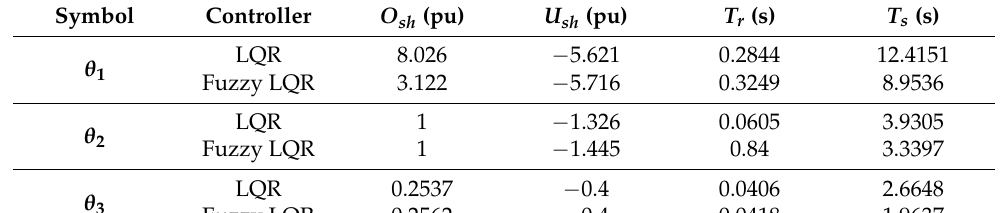
Figure 9. ( a ) The system response for link-1 of Robogymnast in Case 2 (T1); ( b ) The system response for each middle link of Robogymnast in Case 2 (T2); ( c ) The system response for link-3 of Robogymnast in Case 2 (T3). Table 5. Comparison performance of LQR and FLQR controllers in Case 2.